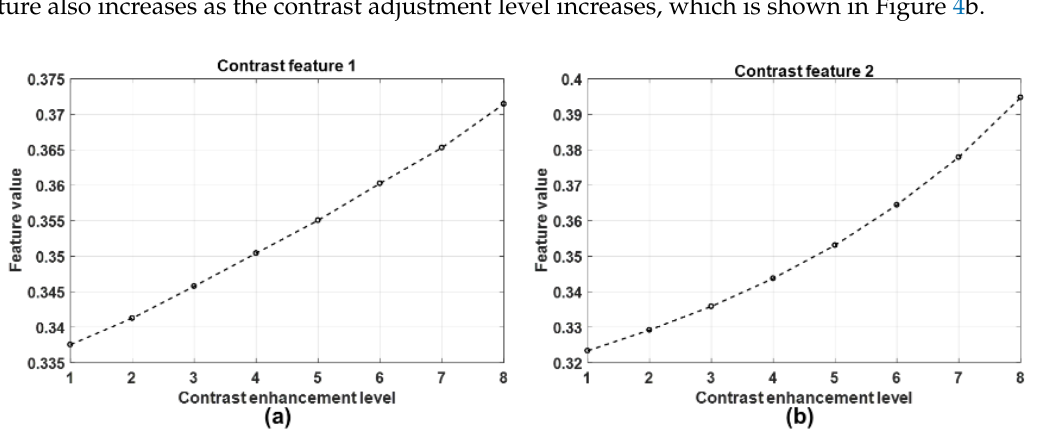
Figure 4. Comparison graph between the contrast adjustment level and the calculated contrast features. Contrast feature 2 and 1 represent the local and global aspects of the contrast of the image, respectively.